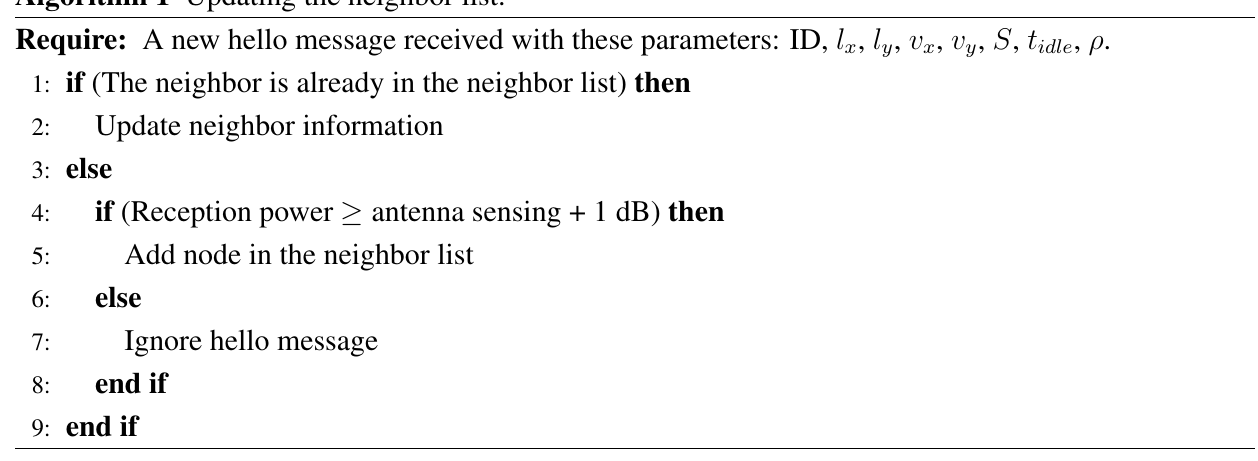
Algorithm 1 Updating the neighbor list.